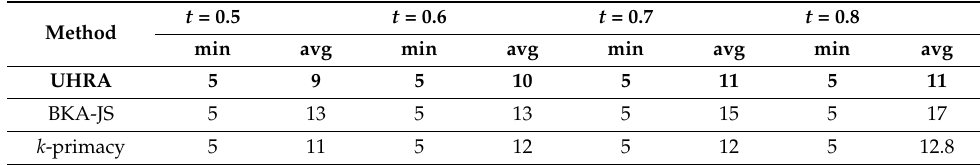
Table 5. The size of QI groups on Adult dataset with J = 0.8 and k =